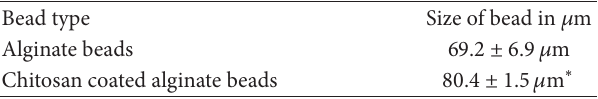
Table 1: Size of L . plantarum alginate beads (AL) and chitosan coated alginate beads